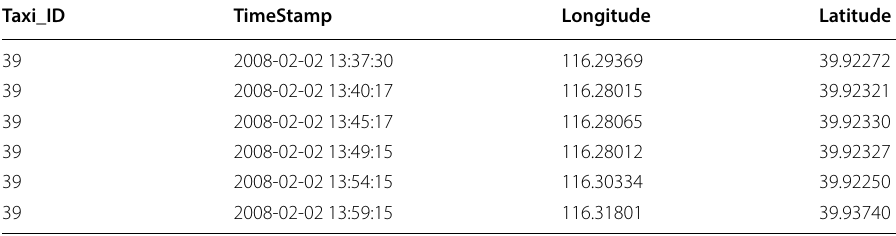
Table 1 Saptio-temporal tracking record of taxi driver